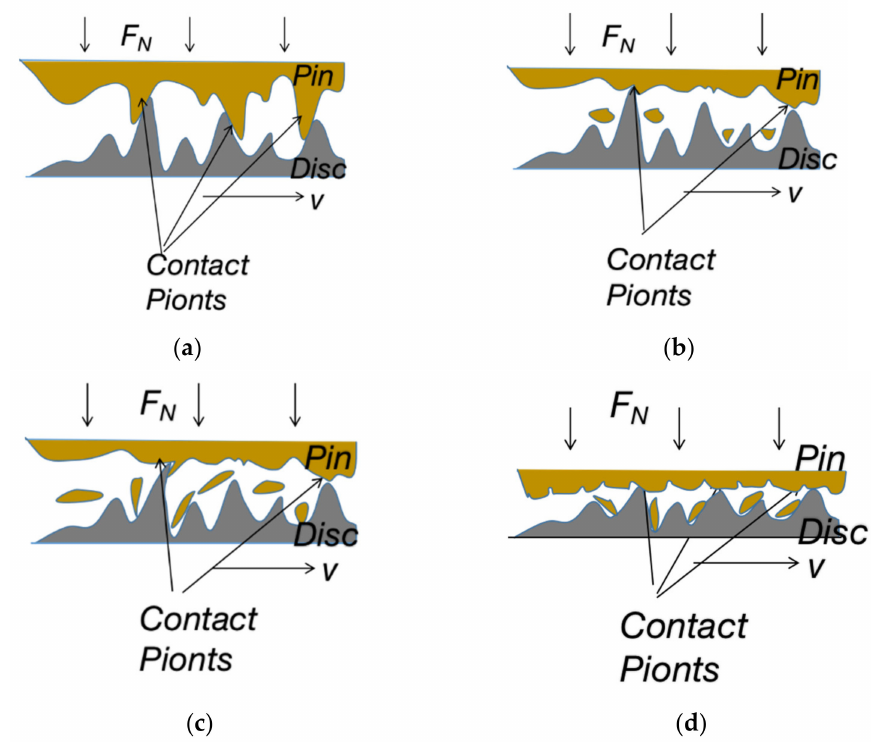
Figure 12. Schematic diagram of establishing the stable process for the friction coefficient under a heavy load of 45 N: ( a ) establishment contact; ( b ) early running-in period; ( c ) later running-in period; and ( d ) stable